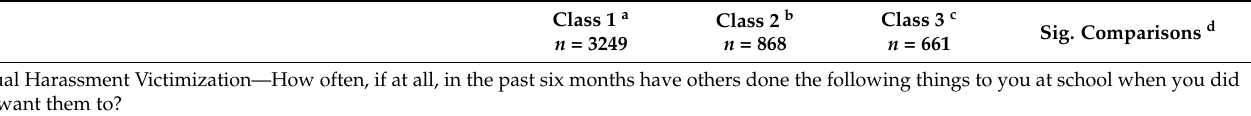
Table 5. Descriptive Statistics for Each Item by Latent Class.